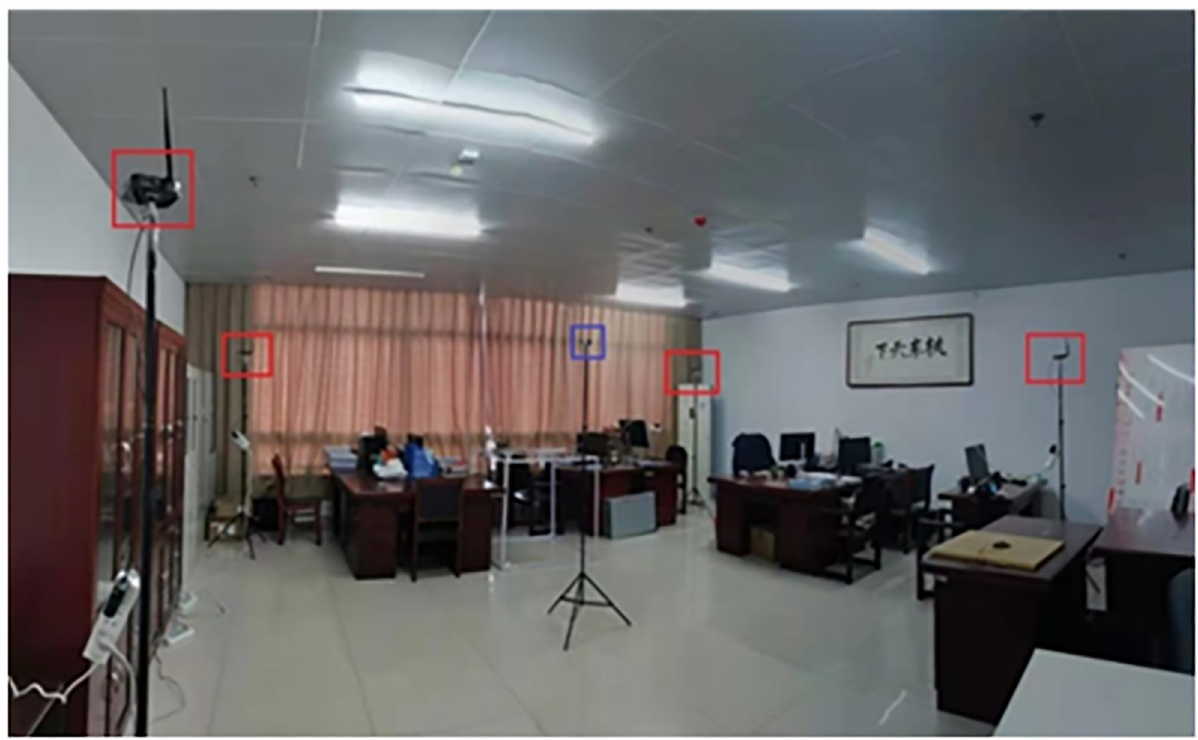
Fig 8. The positioning scenario of